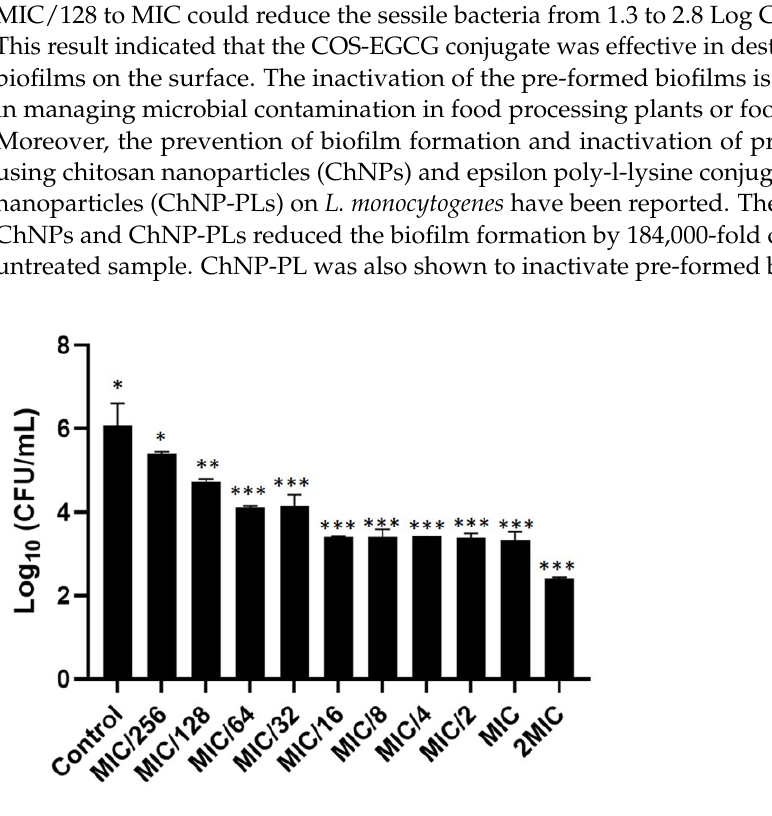
Figure 4. Time-kill curve of L. monocytogenes after treatment with COS-EGCG conjugate at different concentrations, as well as the control with 0.01% acetic acid in the TSB medium. The results are presented as means ± SD ( n = 3) .